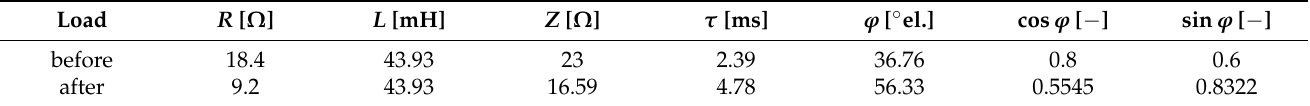
Table 12. Load parameters for steady states before and after load change.